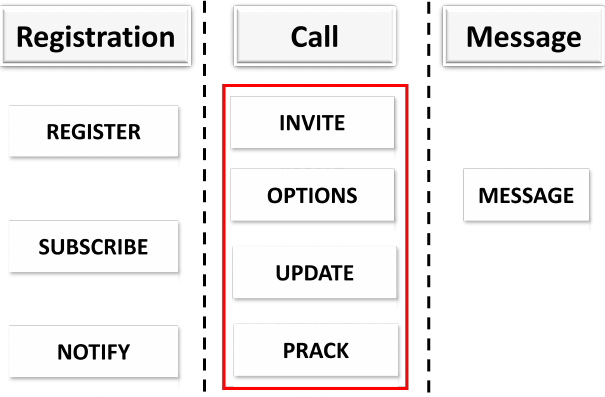
Figure 5. SIP requests categorization.